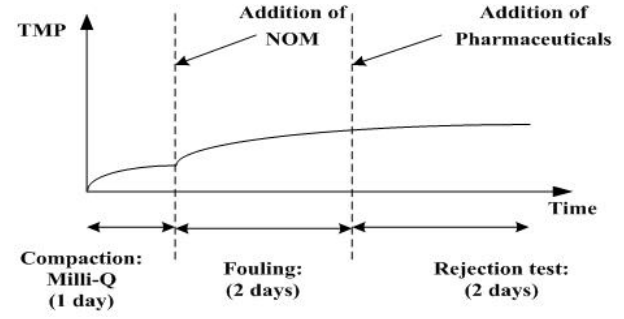
Figure 2. Filtration protocol for compaction, fouling and rejection